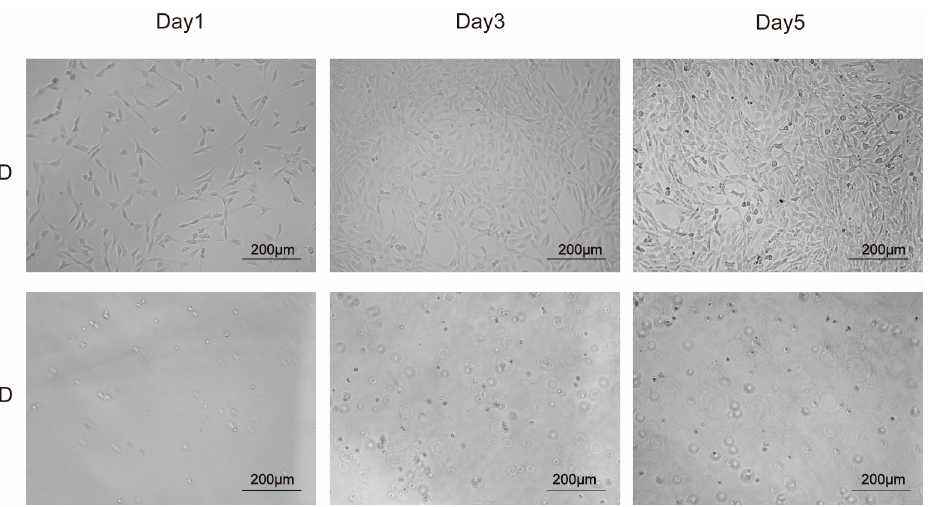
Figure 3. Microscopic morphology of NIH3t3 at days 1, 3, and 5 in 2D and 3D cultures. The 2D group did not have peptide added, and the 3D group had 50 µ L of SCIBIOIII peptide solution added in each well.